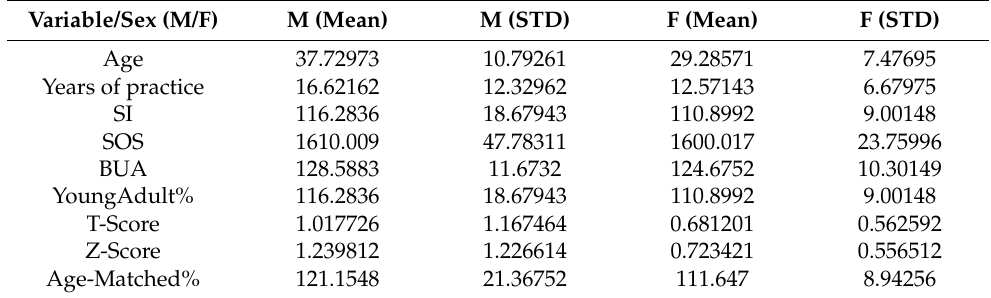
Table 3. The breakdown table of descriptive statistics of mean values and standard deviations of variables characterizing the females and males in the study group.